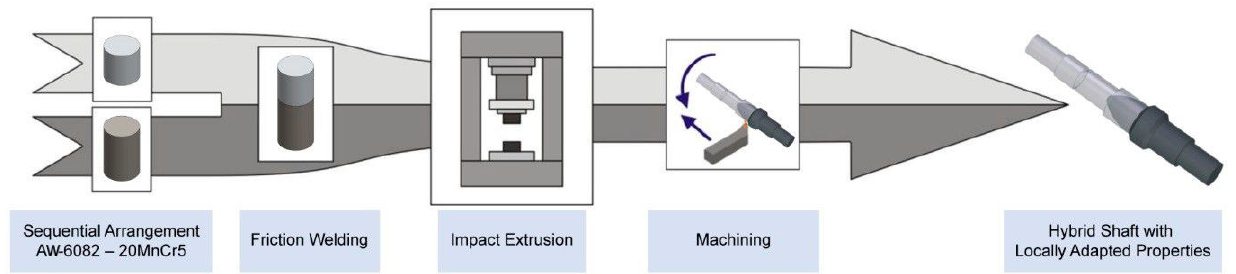
Figure 1. Schematic tailored forming-process chain of the collaborative research center 1153 (CRC 1153) [8], material combination EN AW-6082 (AA6082) and 20MnCr5.